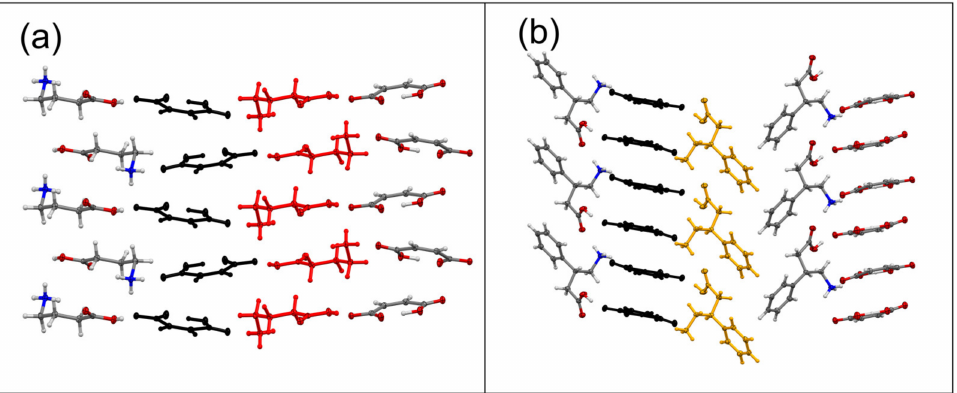
Figure 1. Packing in ( a ) 1-MA , view along the a-axis and ( b ) 4-MA view along the b-axis. Rows are highlighted according to the chosen color scheme; oxygen atoms are depicted in red, nitrogen atoms in white, carbon atoms in grey, and hydrogen atoms in white.